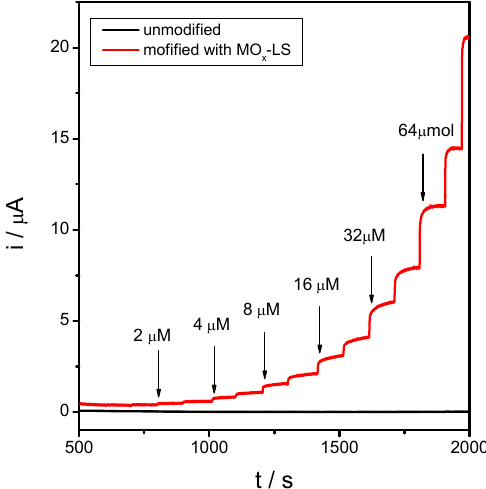
Figure 7. Comparison of amperometric response of unmodified GC electrode and the electrode modified with MnO x -LS towards increasing concentrations of hydrogen peroxide.